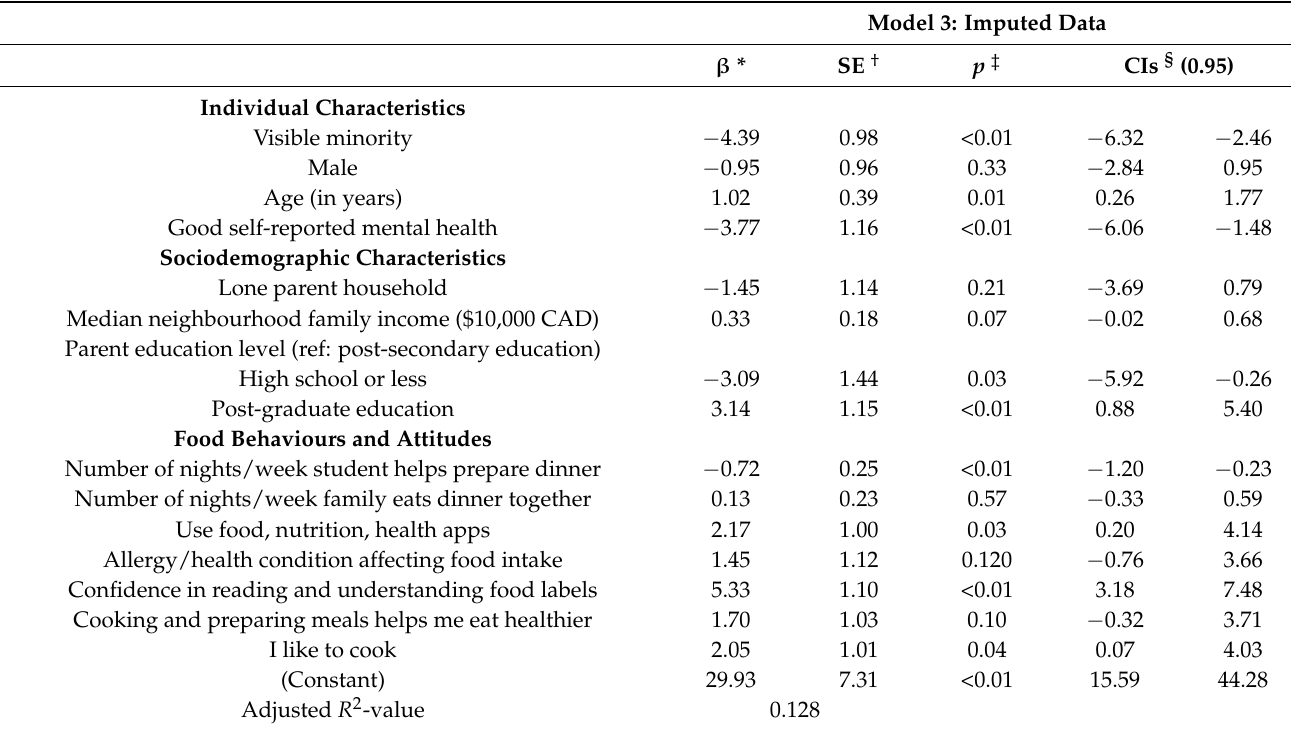
Table 6. Multiple Linear Regression for Total Knowledge Score (N =